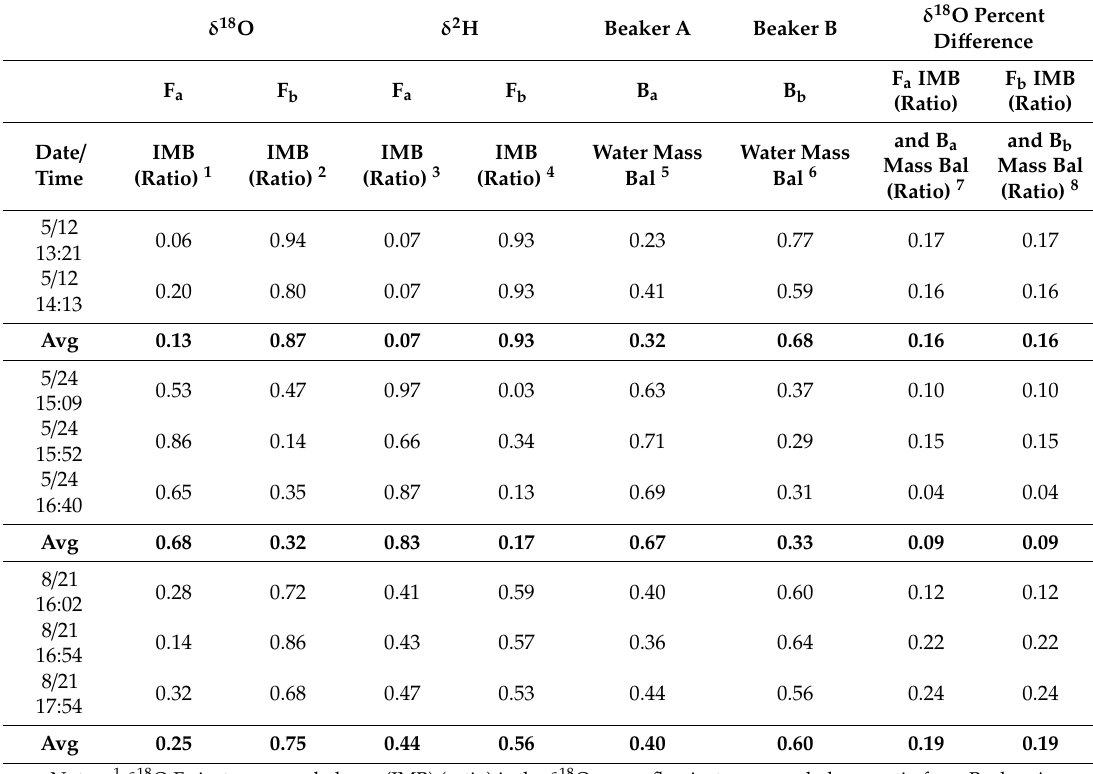
Table 1 corresponds to observations from the three lab experiments. Water mass balance ratios were largely comparable to ratios of the IMB. Further discussion on uncertainty is in Section 5. Table 1. Isotope (IMB) and water mass balance ratios measured from three laboratory experiments and ratio di ff erences between each water-vapor